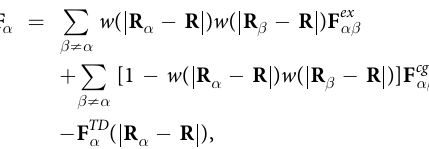
where both representations are superimposed. The coupling between different levels of resolution is achieved via a force interpolation scheme. The total force acting on a molecule α is given by ∑ =